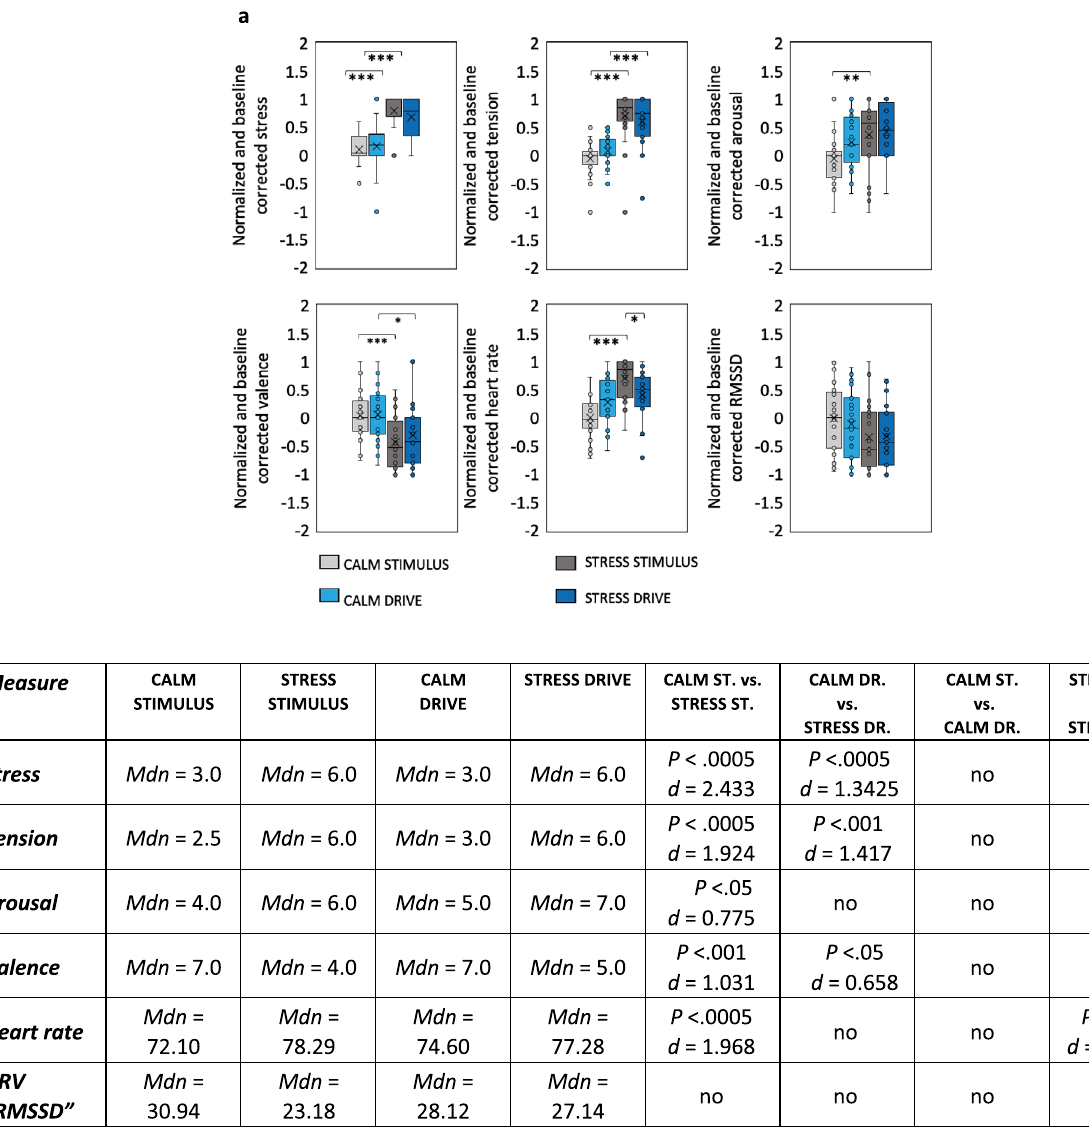
Figure 2. Results of the stressor validation analysis to establish a ground-truth assessment of whether participants were more stressed during stress exposure compared to calm conditions. ( a ) Boxplots of normalized and baseline corrected subjective and psychophysiological metrics. Permutation probability P values are corrected for multiple-comparisons with *** P < 0.001; ** P < 0.01, and * P < 0.05. ( b ) Permutation results with adjusted probability p values after Bonferroni correction, and Cohen’s d as effect size measure